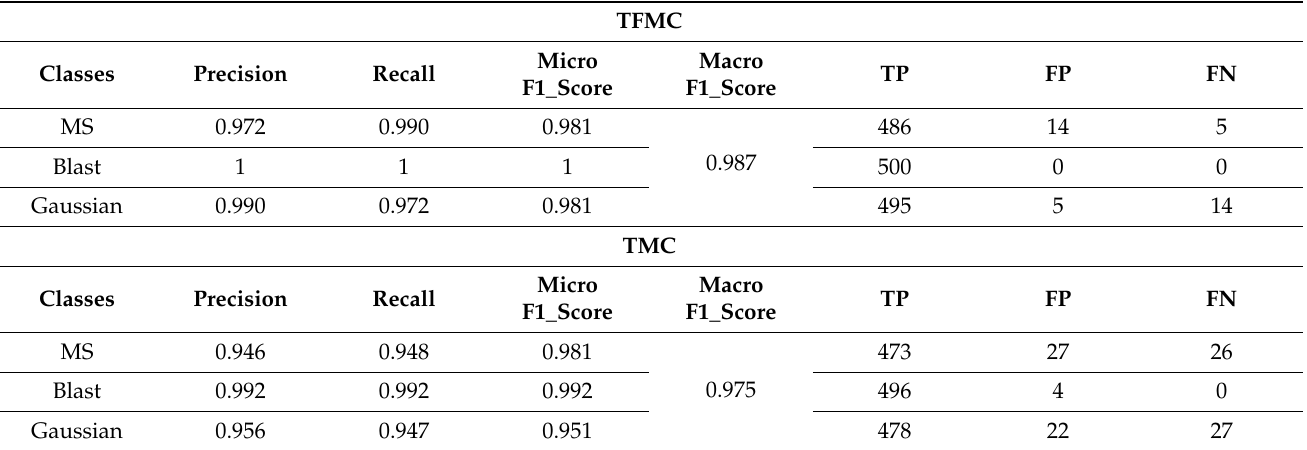
Table 6. Comparison between the TFMC and TMC methods on the test dataset containing MS, Blast noise, and Gaussian noise data.